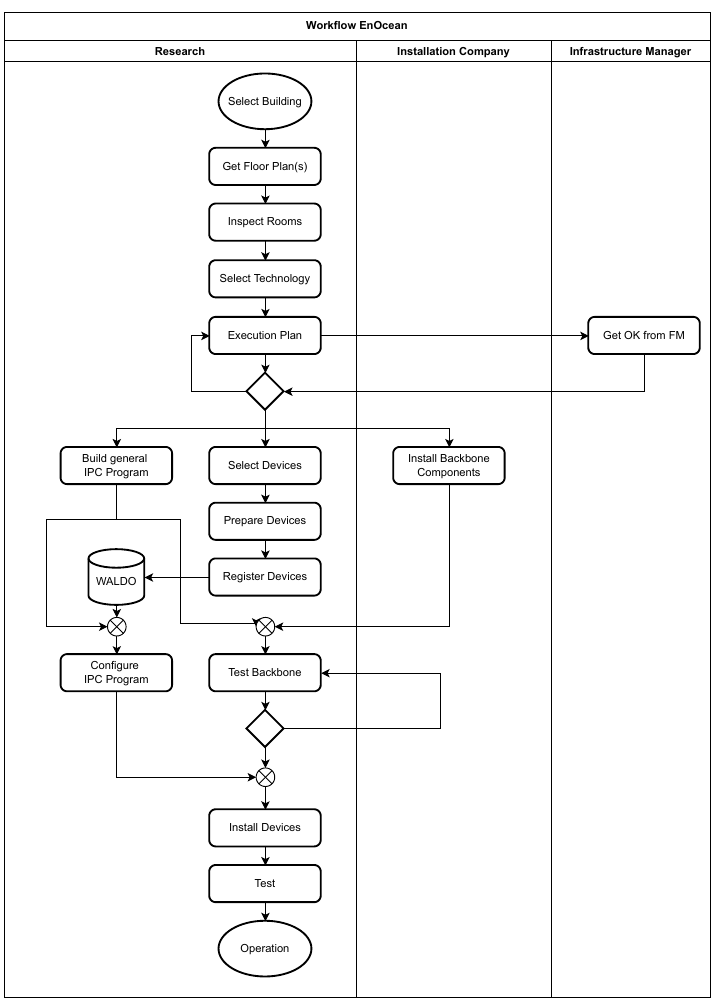
Figure 6. Proposed workflow for the selection, provisioning, and installation of devices that use the EnOcean